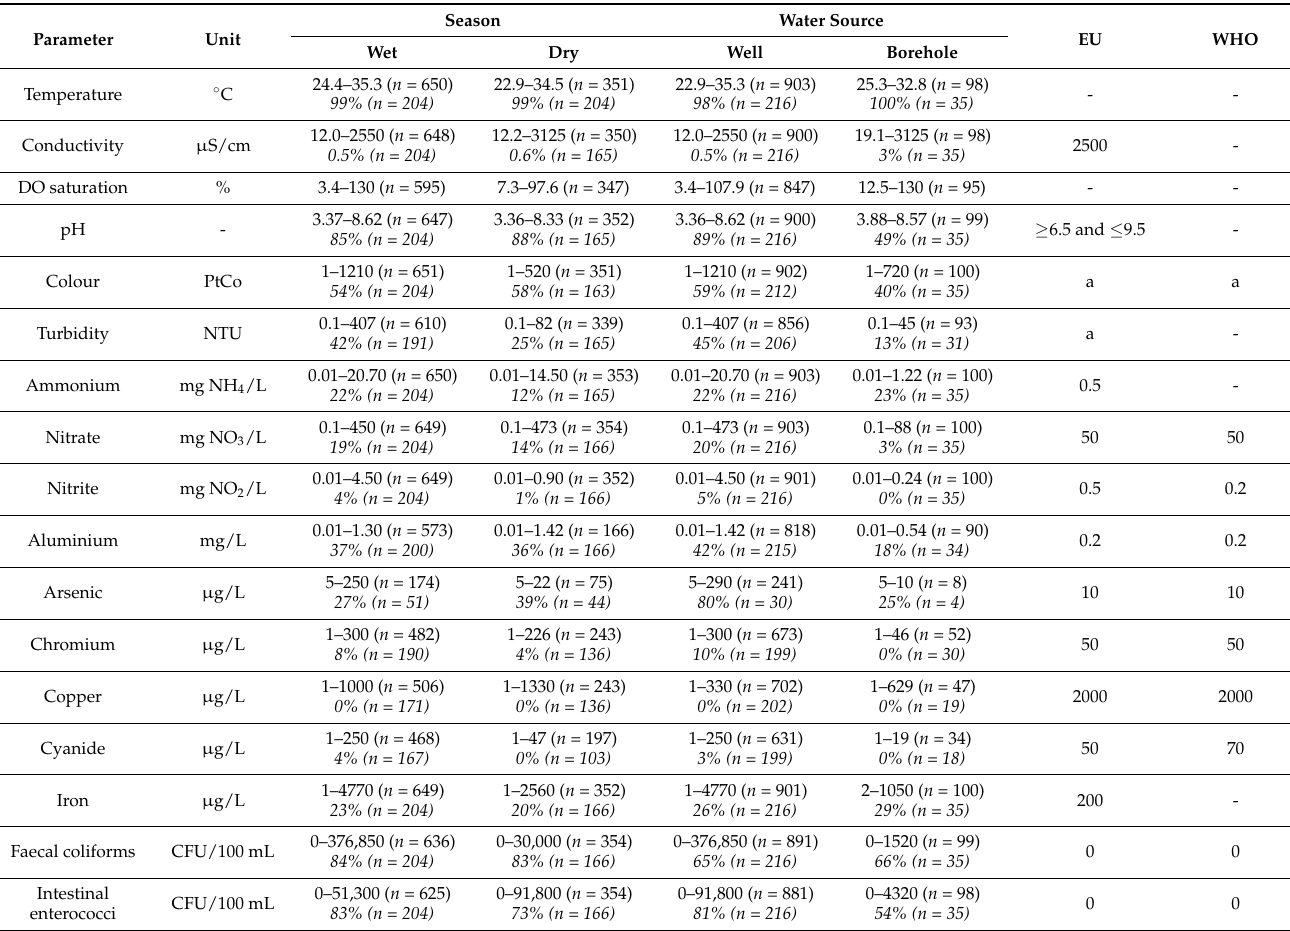
Table 1. Minimum and maximum values for water quality parameters seasonally assayed, according to water source type. In italics are the percentage of sites above the parametric values for drinking water, and the respective number of water sources surveyed. EU—European Union parametric values for drinking water [19], WHO—Word Health Organization guidelines values for drinking water